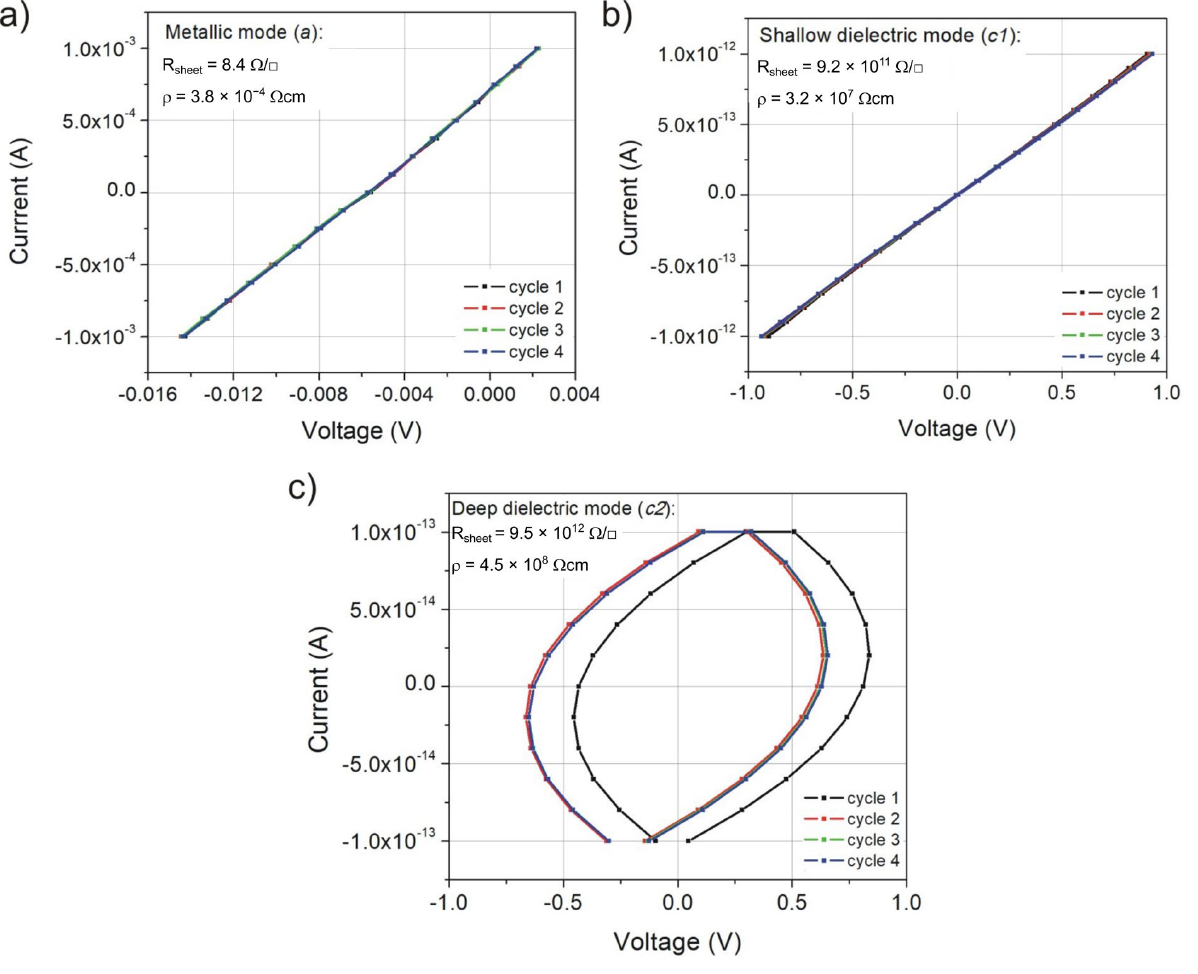
Figure 10. Current-voltage characteristics for ZnOx thin films deposited at modes: ( a ) metallic ( a ), ( b ) shallow dielectric ( c1 ) and ( c ) deep dielectric ( c2 ).